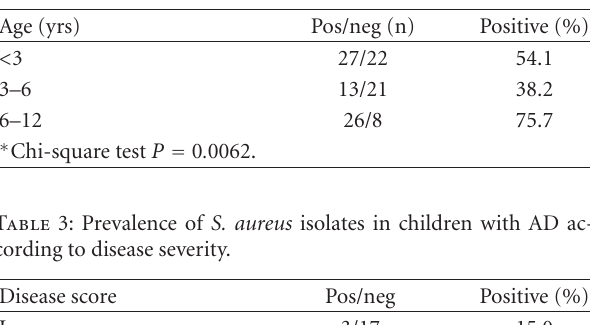
Table 2: Prevalence of S. aureus isolates in children with AD ac- cording to age.